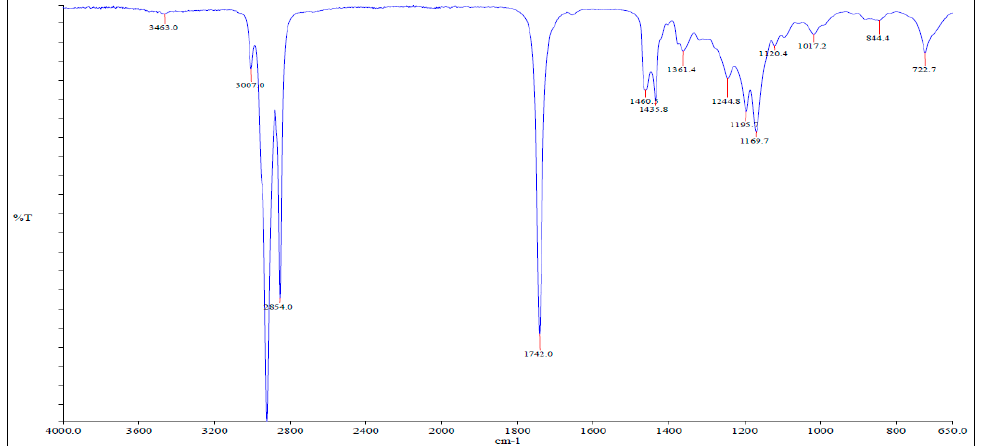
Figure 4. Fourier transform infrared (FTIR) spectrum of SFO biodiesel.